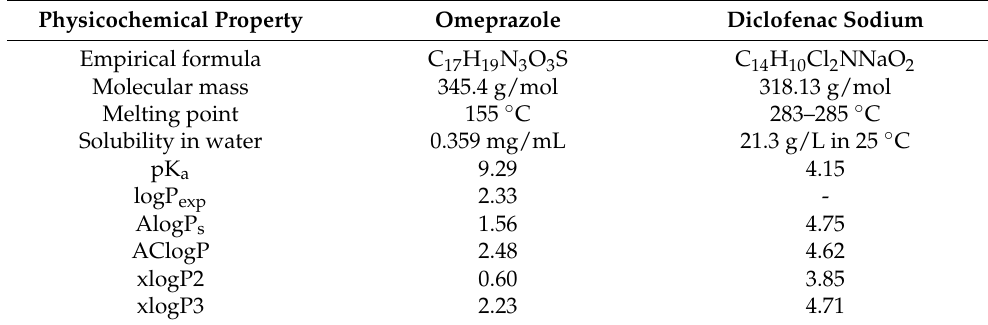
Table 1. Selected physicochemical properties of omeprazole and diclofenac sodium [9 – 13].